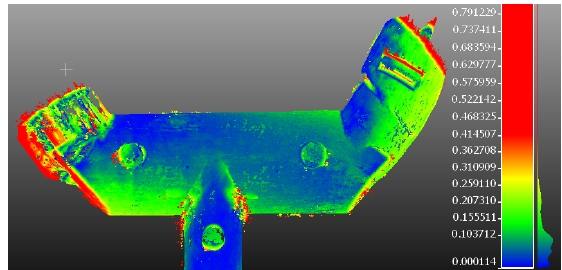
Figure 8. Error map for scale = 2.35. Figure was obtained from CloudCompare. Red values corresponds to higher error values. Values are saturated at 41cm (red values start approximately at 33cm, as shown in the color bar on the right).